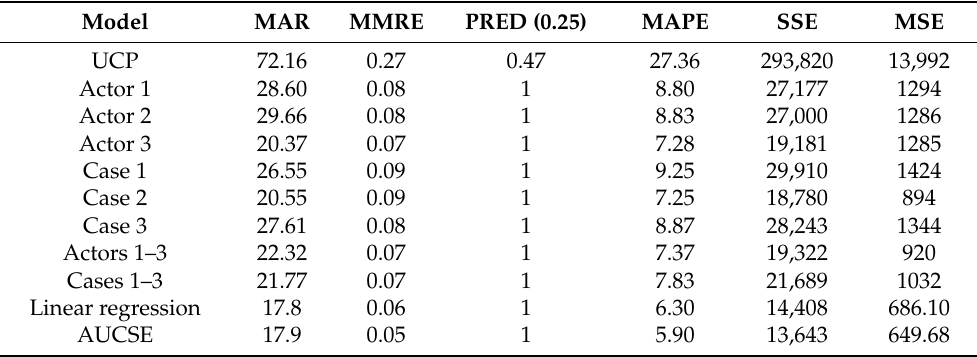
Table 3. Comparison of AUCSE to other model variants.